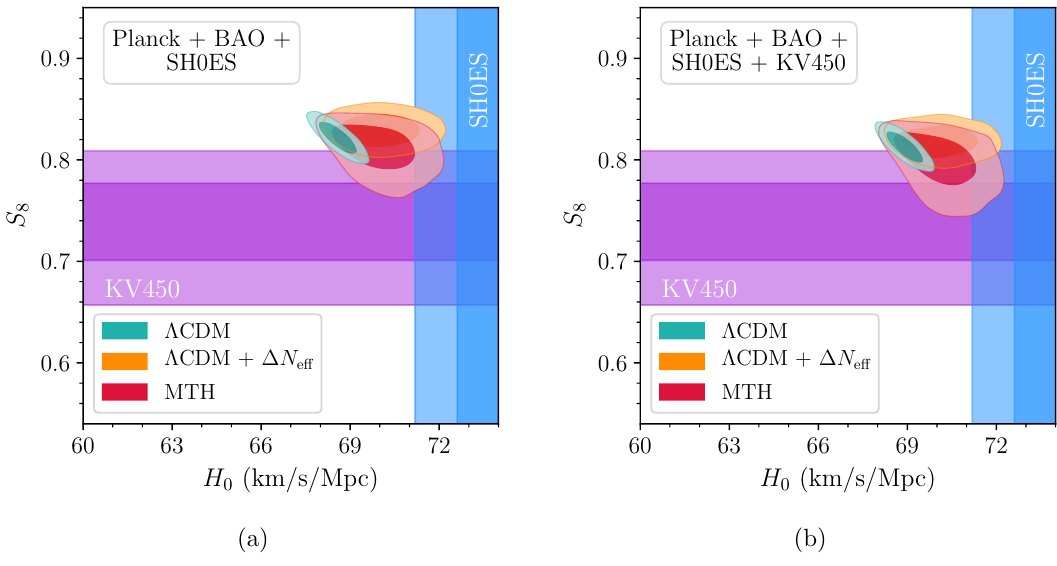
Figure 13. The preferred ranges of the parameters S 8 ≡ σ 8 (Ω m / 0 . 3) 0 . 5 and H 0 for the three models: Λ CDM, Λ CDM + ∆ N ( > 0) , and the MTH model using the Planck, BAO, and SH0ES eff datasets (figure 13(a)), and with the addition of the KV450 data (figure 13(b)). For reference, the measurements by H by SH0ES and S by KV450 are also shown in blue and violet, respectively. 0 8 The MTH fit with KV450 data is done using the linear matter power spectrum, while the Λ CDM and Λ CDM + ∆ N ( > 0) analyses include the non-linear corrections computed by Halofit. We eff include non-linear corrections to the MTH fit from HMcode and Halofit in figure